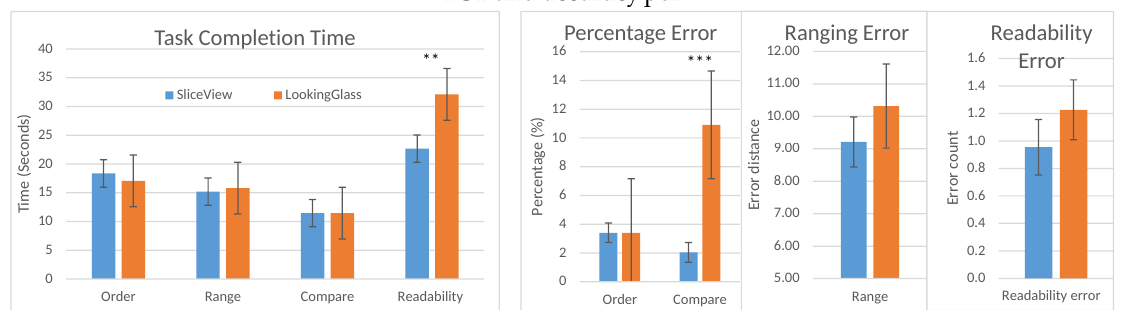
Figure 10. Task Completion Time and Accuracy split by condition and subtask. (** refers to p -value ≤ 0.01; *** refers p -value ≤